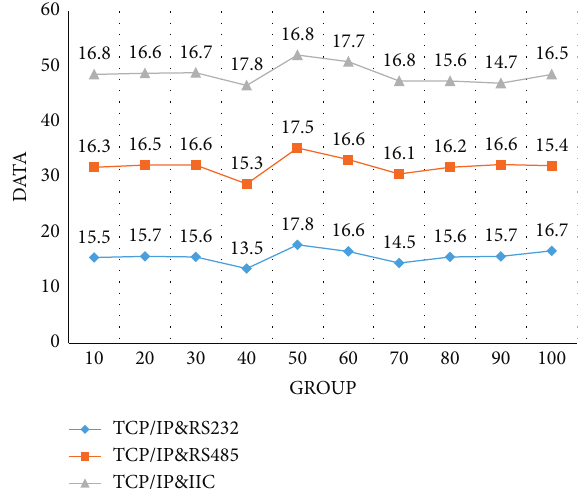
Figure 2: The mean delay variation between ports.